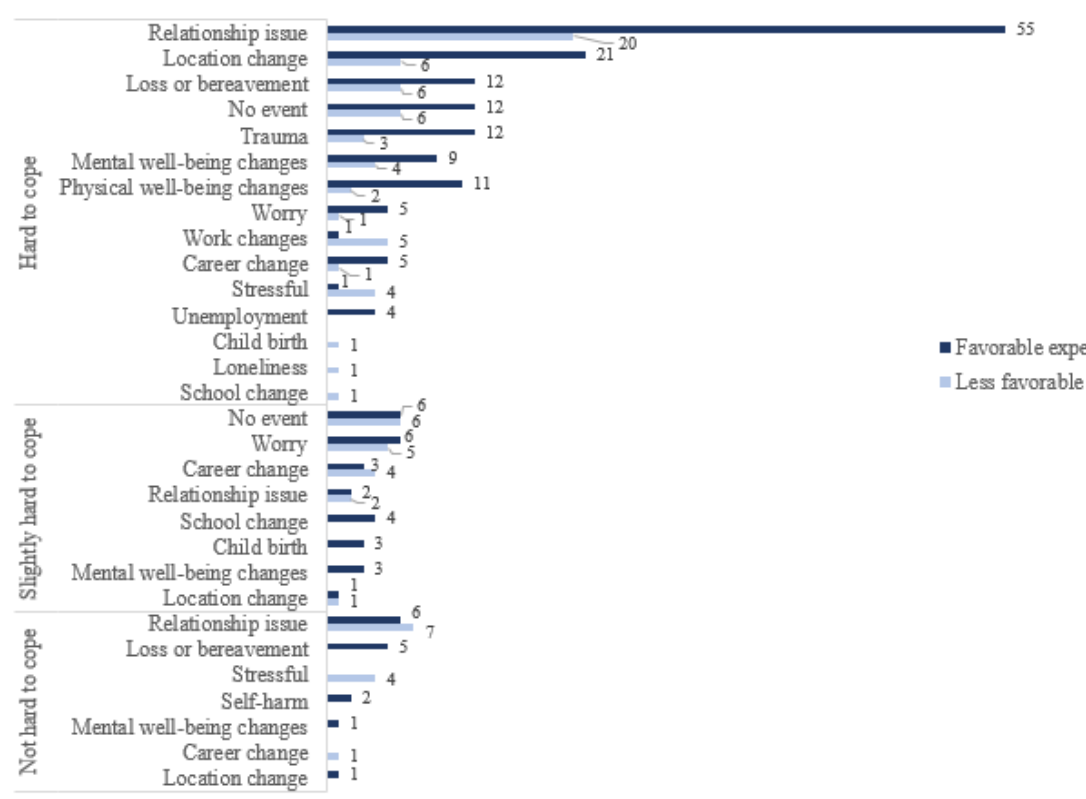
Figure 4. Coping major event-app experience-based feedback response distribution.